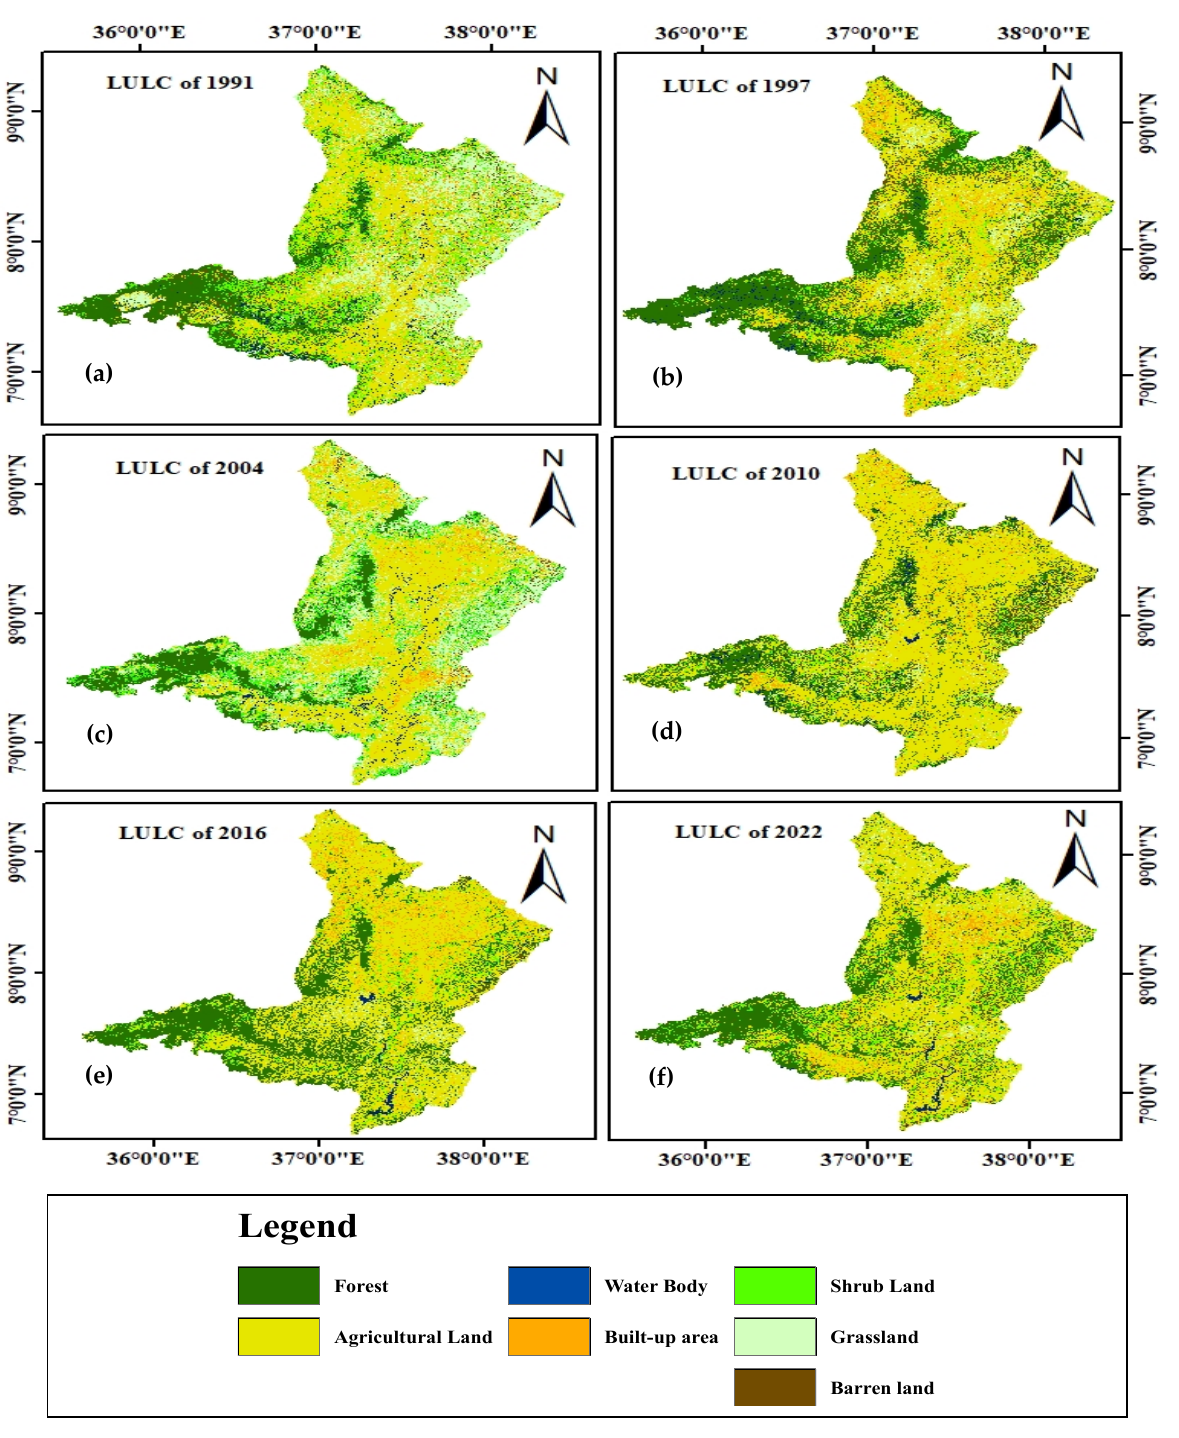
Figure 3. Land use/land cover (1991–2022): ( a ) LULC of 1991, ( b ) LULC of 1997, ( c ) LULC of 2004, ( d ) LULC of 2010, ( e ) LULC of 2016, and ( f ) LULC of 2022.